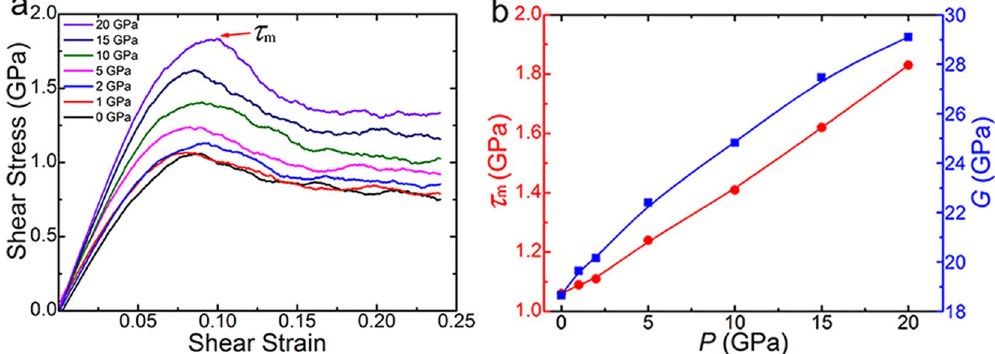
Figure 6. The MD simulations of the shear deformation in Zr 50 Cu 44 Al 6 MG samples prepared under various hydrostatic pressures. ( a ) The shear stress-strain curves on which the maximum value τ m is defined as the shear strength. ( b ) The shear strength and the shear modulus are enhanced by the increasing pressure.